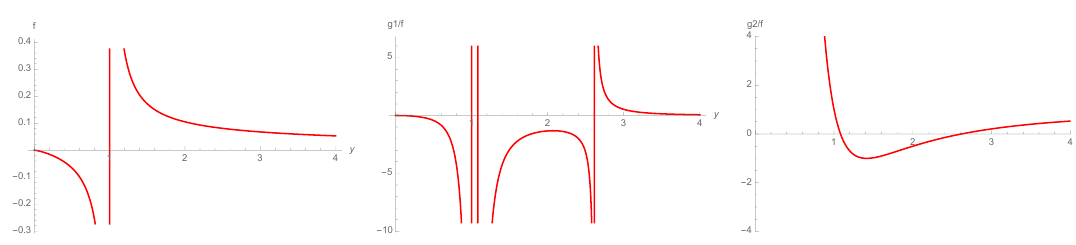
Figure 1 . A representative solution with b = − 0 . 5 and C = 1 . The solution is regular in the range of y = 2 . 6131 < y < ∞ 1